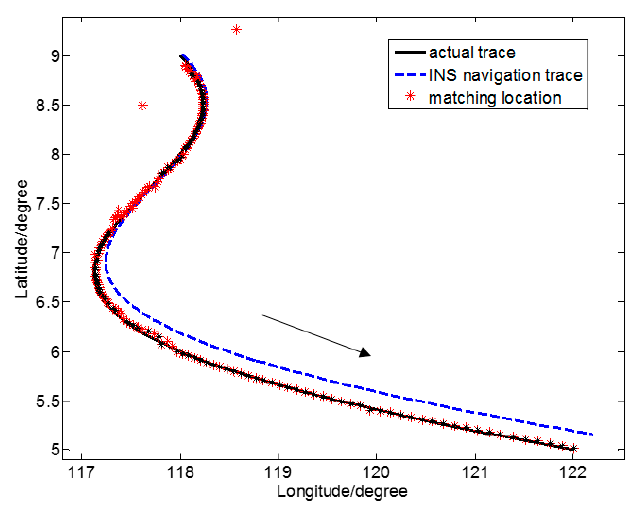
Figure 6. Simulation trace of irregular sailing route gravity matching (sailing route B).